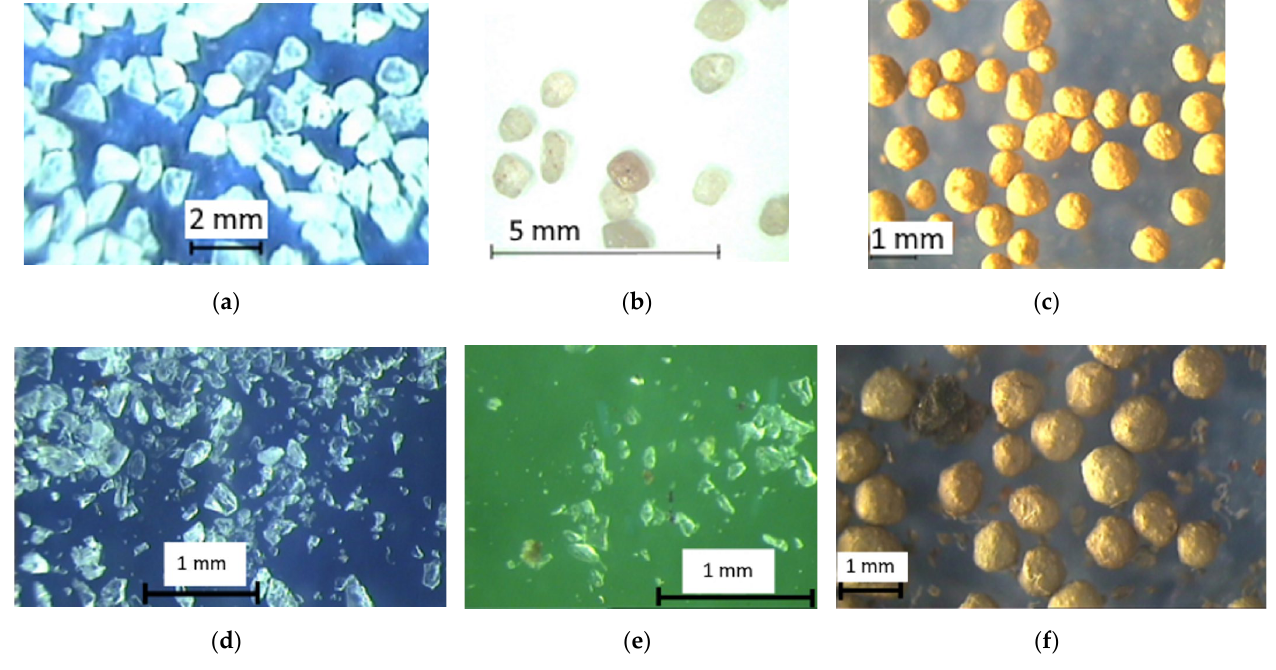
Figure 5. Particle shape and granulometric composition of model mechanical impurities: ( a – c )—initial shape and composition; ( d – f ) after passing through 80 working stages, 7A-150, of the tested section of the electric centrifugal pump; ( a , d ) particles of artificial quartz sand; ( b , e ) particles of river sand; and ( c , e ) proppant.